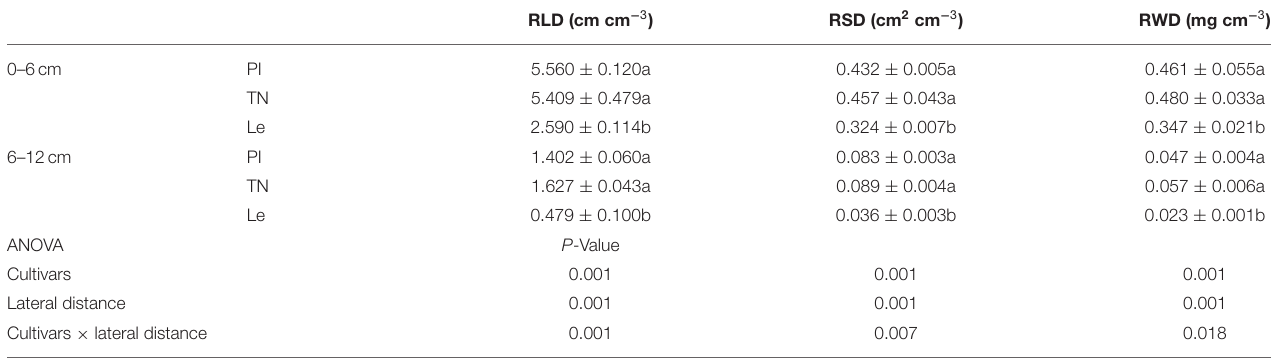
TABLE 1 | Effects of different rice cultivars and lateral distance on root distribution.